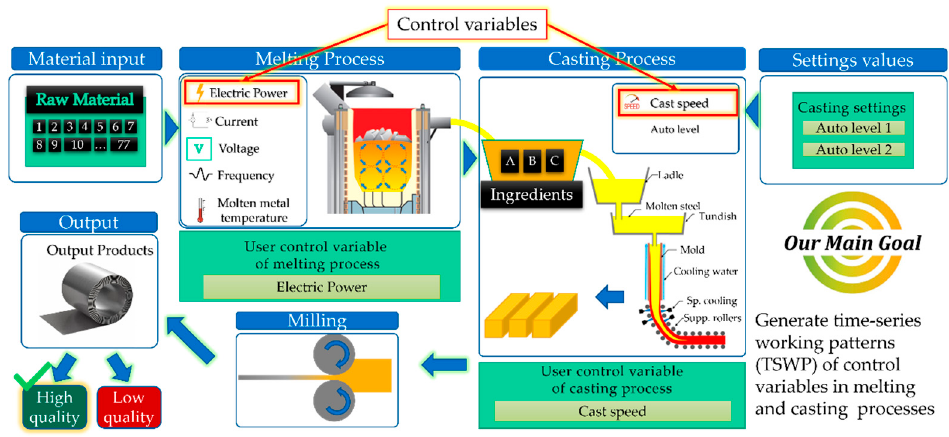
Figure 1. Overall process of metal production.